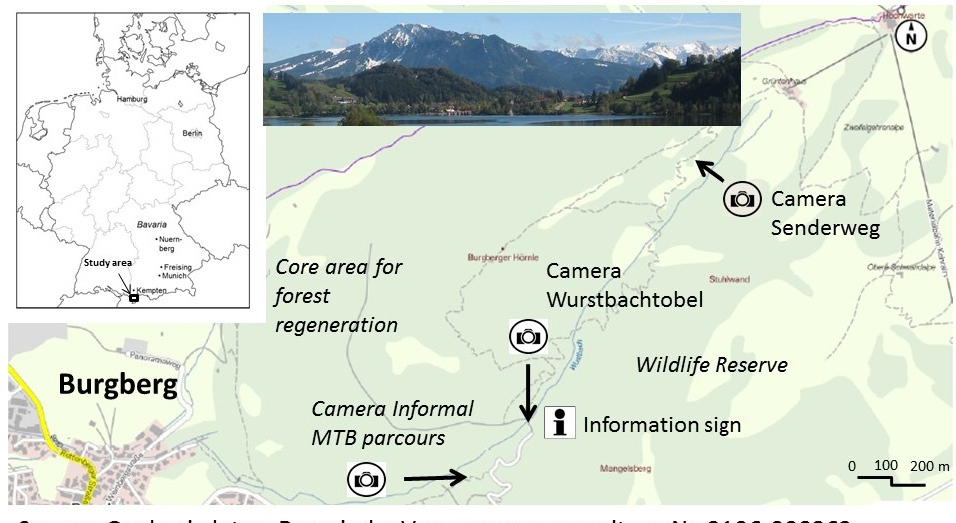
Figure 3. Map of the monitoring sites at Grünten Mountain, 20 km south of Kempten, Bavaria, Germany. For camera types, sites, visitor monitoring questions, and data assessment, see Appendix A, Table A1.